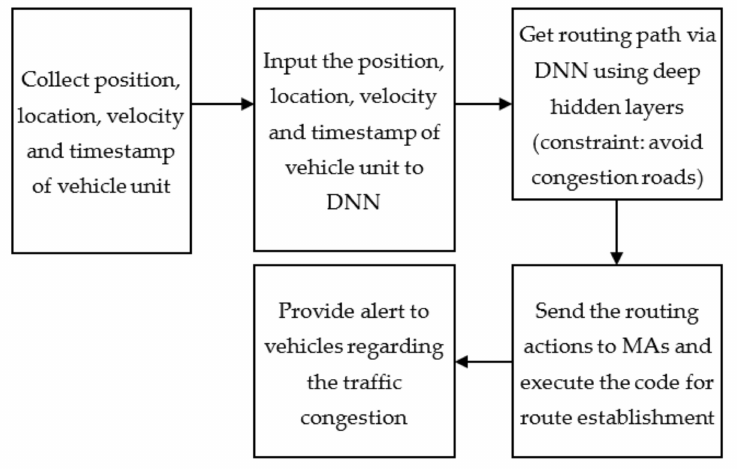
Figure 3. Infrastructure Unit